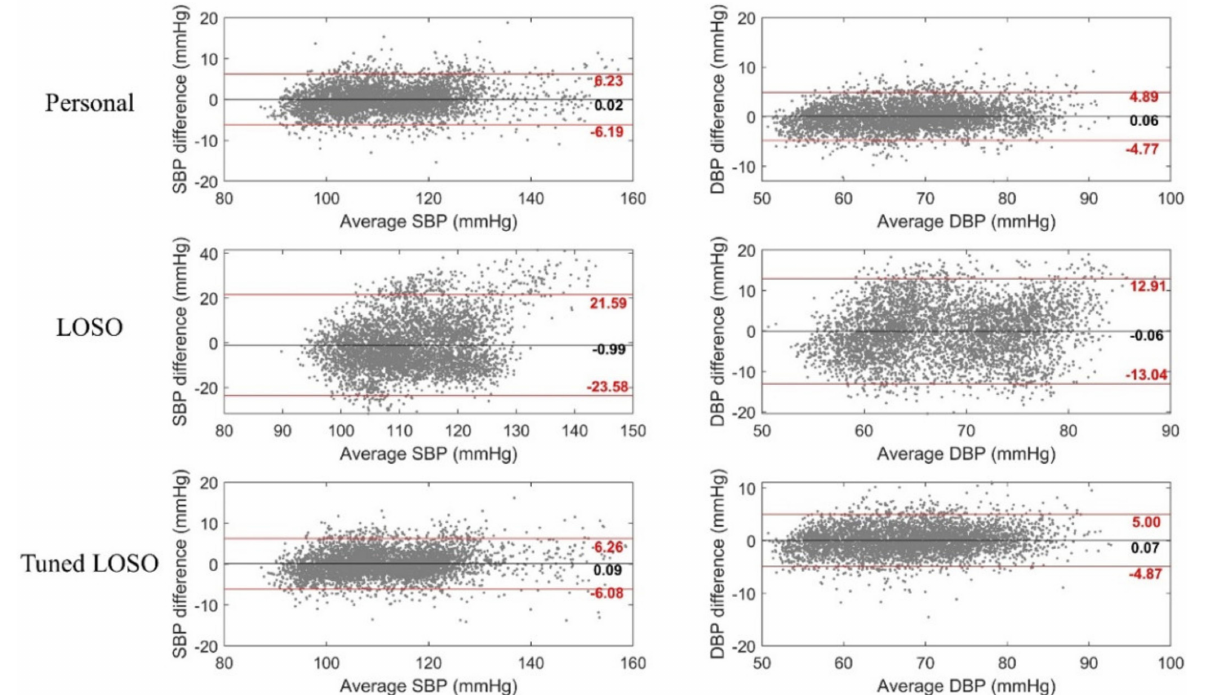
Figure 6. Bland–Altman plots of models. Black line: mean value; red line: 95% confidence